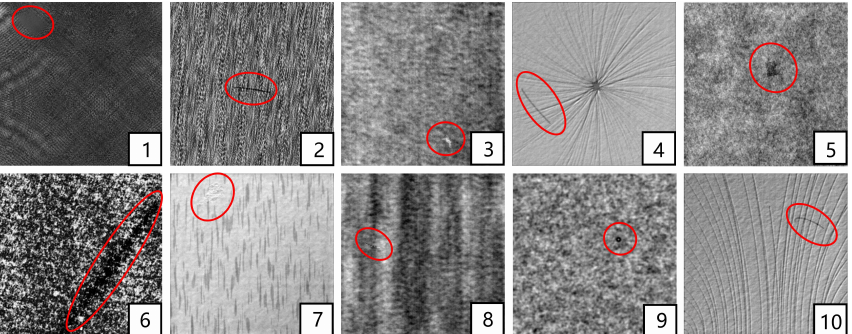
Figure 11. The image samples of 10 classes in DAGM2007 dataset. Defects are marked with red ellipses.